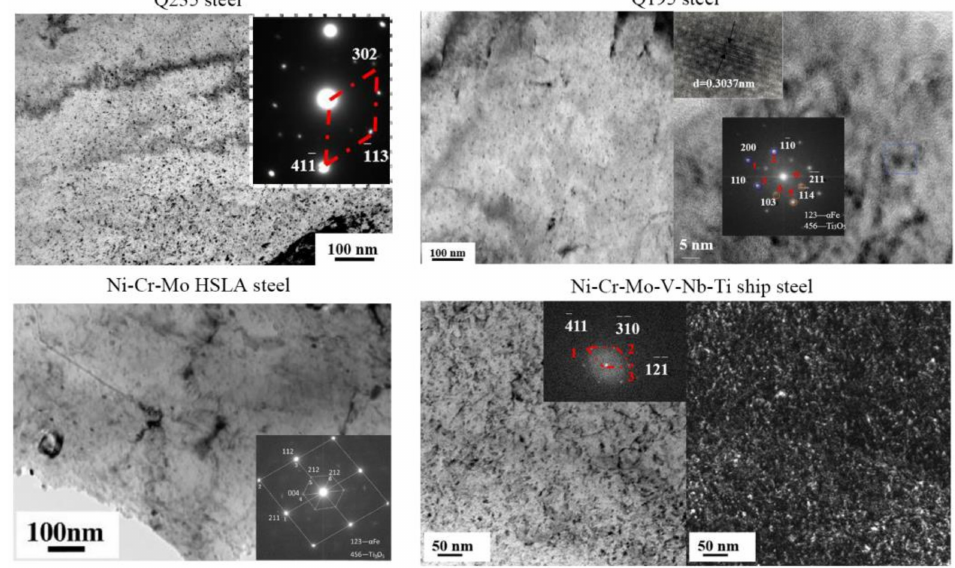
Figure 8. TEM images and corresponding selected area diffraction pattern (SADP) of in-situ nanoparticles in as-cast Q235 steel [59], Q195 steel [33], Ni-Cr-Mo HSLA steel [58] and Ni-Cr-Mo-V-Nb-Ti ship steel